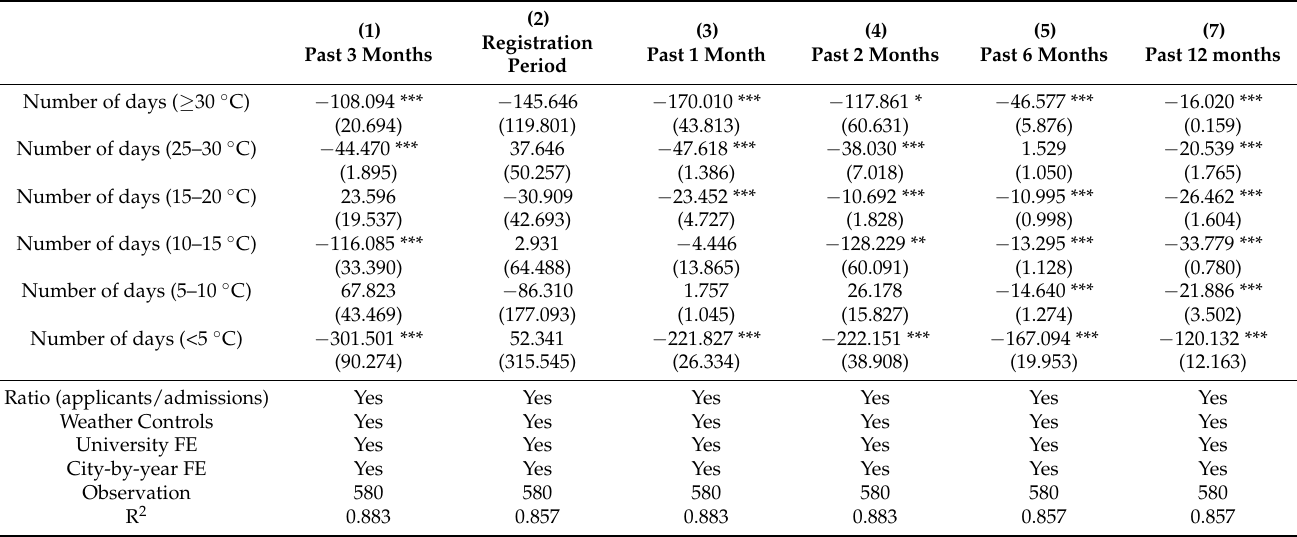
Table 10. Effects of temperature on the number of applicants in different time